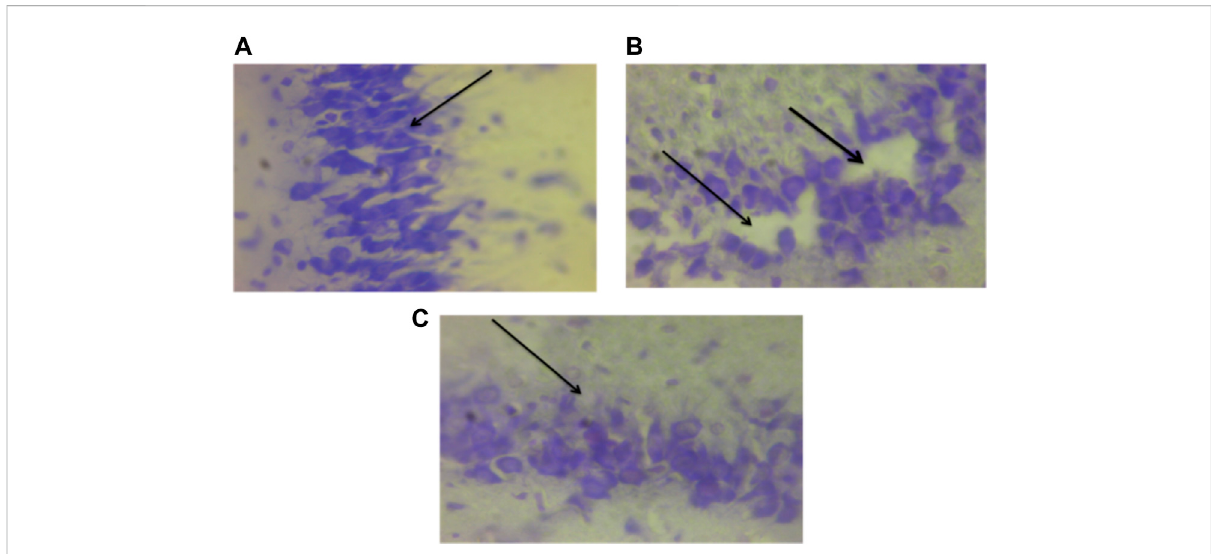
FIGURE 17 PhotomicrographofthehippocampusofTBIandnormalrats; (A) Nontraumatizednontreated(GroupIII)withintactcelllayers, (B) Traumatized non treated rats (Group II) showing distorted layers and cell loss, and (C) DMSO treated rats (Group I) sowing undistorted pyramidal cell layer. DMSO – dimethylsulfoxide. Nissl stain